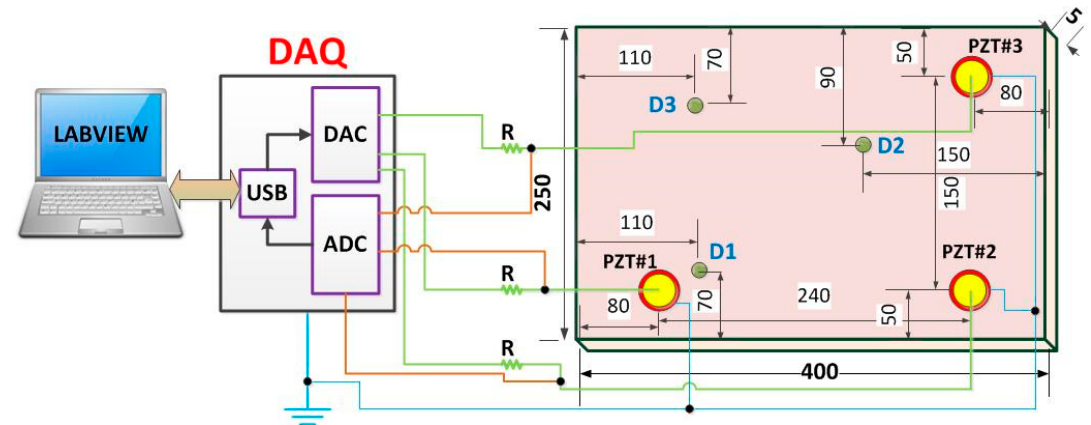
Figure 3. Representation of the general diagram for the acquisition system (dimensions in millimeters) [27].